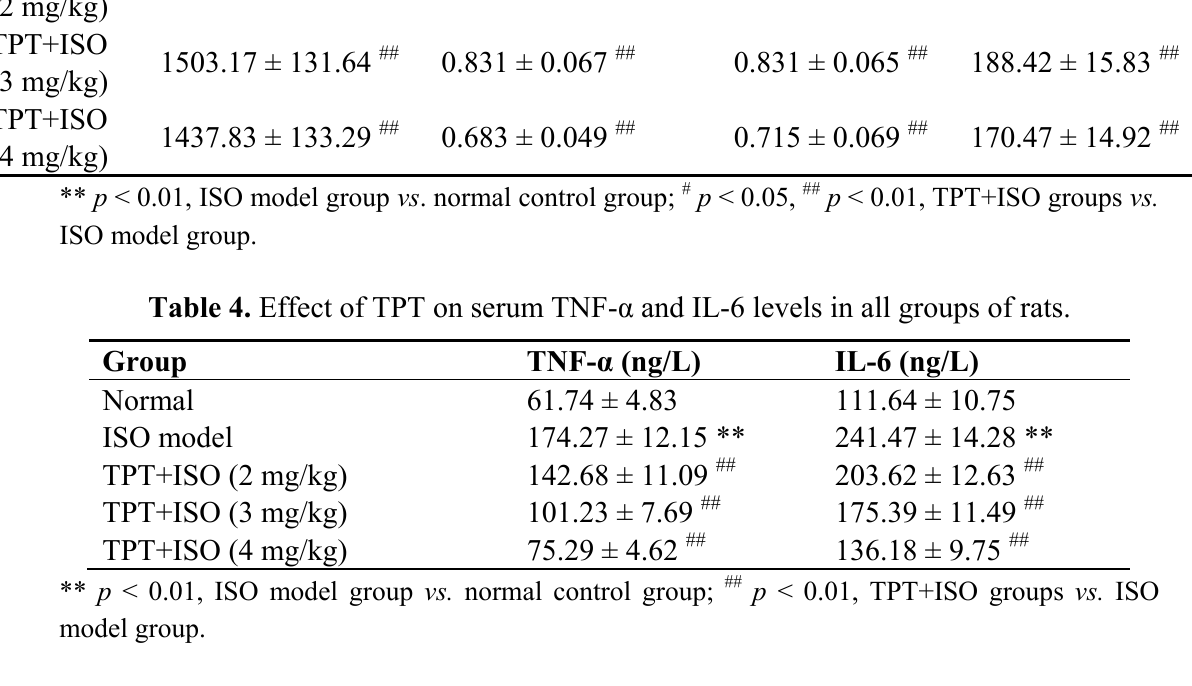
Table 5. Effect of TPT on myocardium MDA and GSH levels, SOD, CAT and GSH-Px activities in all groups of